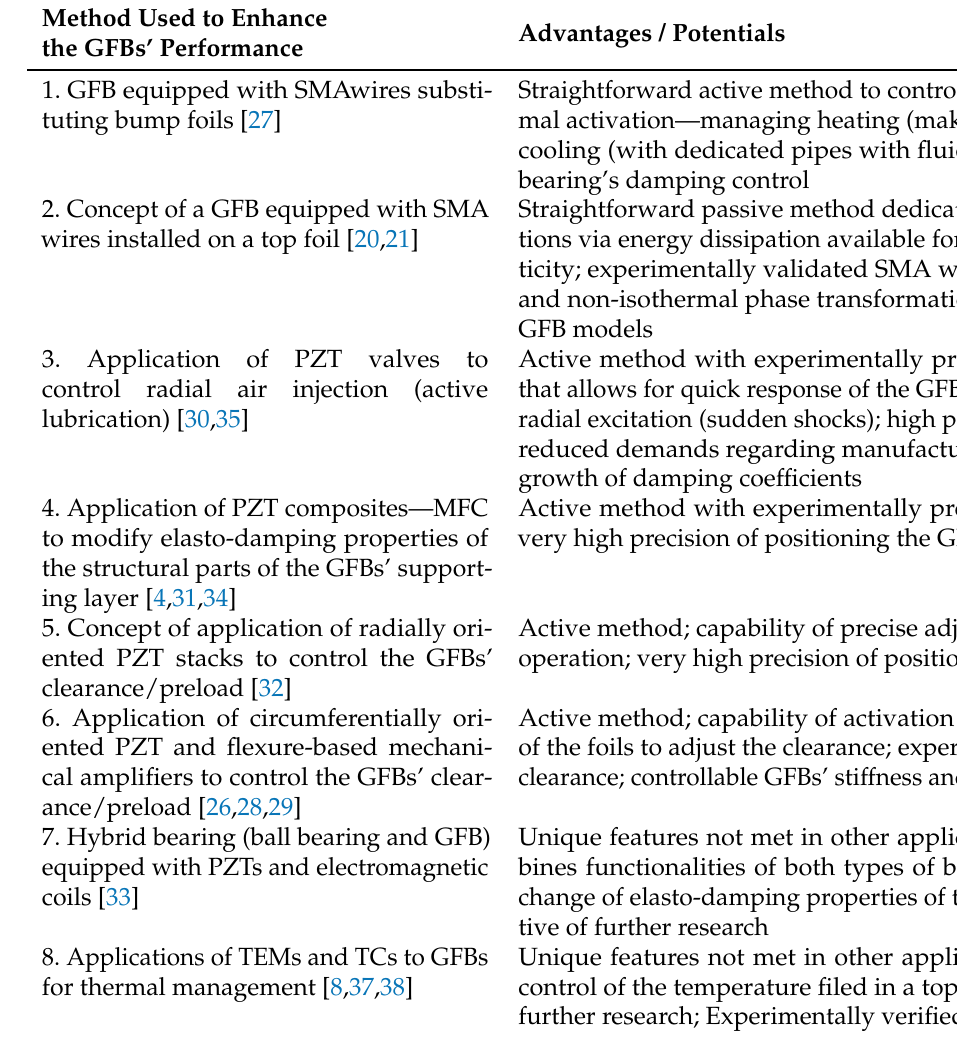
Table 1. Properties of smart material-based GFB